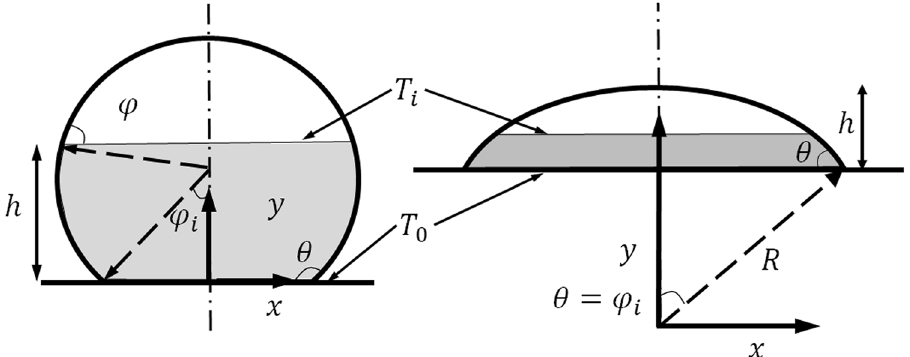
Figure 4. The theoretical model of a water droplet with a contact angle higher than 90° (left), and lower than 90°